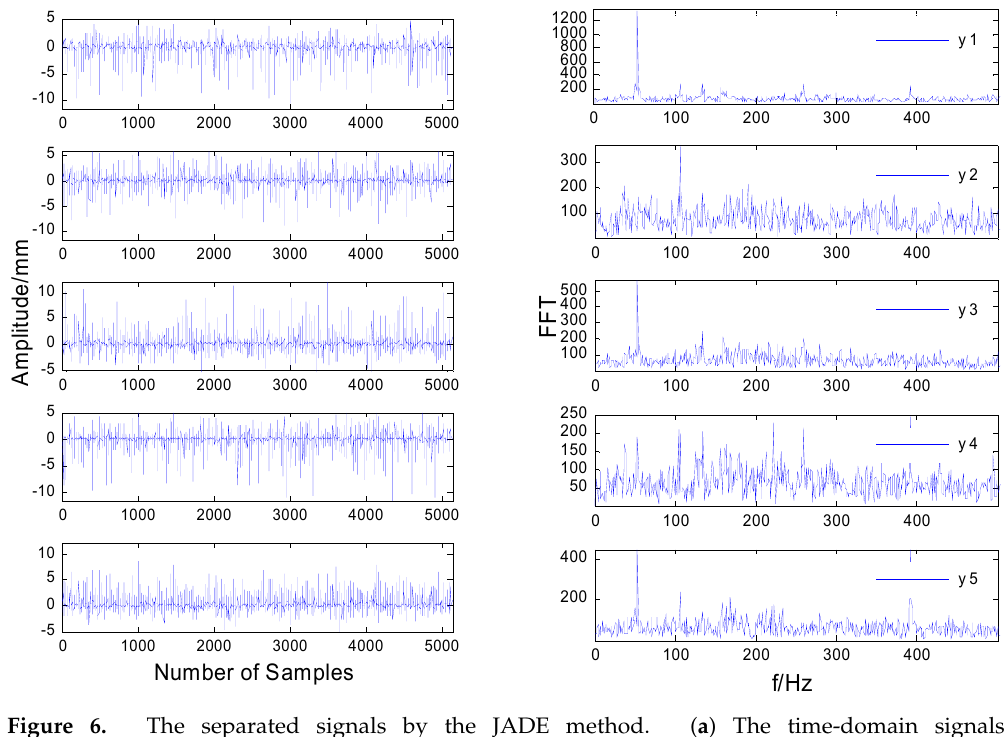
Figure 4. Time-frequency waveforms of rotor vibration signals. ( a ) The time-domain signals. ( b ) The frequency-domain signals. ( a ) Figure 5. The signals separated by FastICA. ( a ) The time-domain signals. ( b ) The frequency-domain signals.